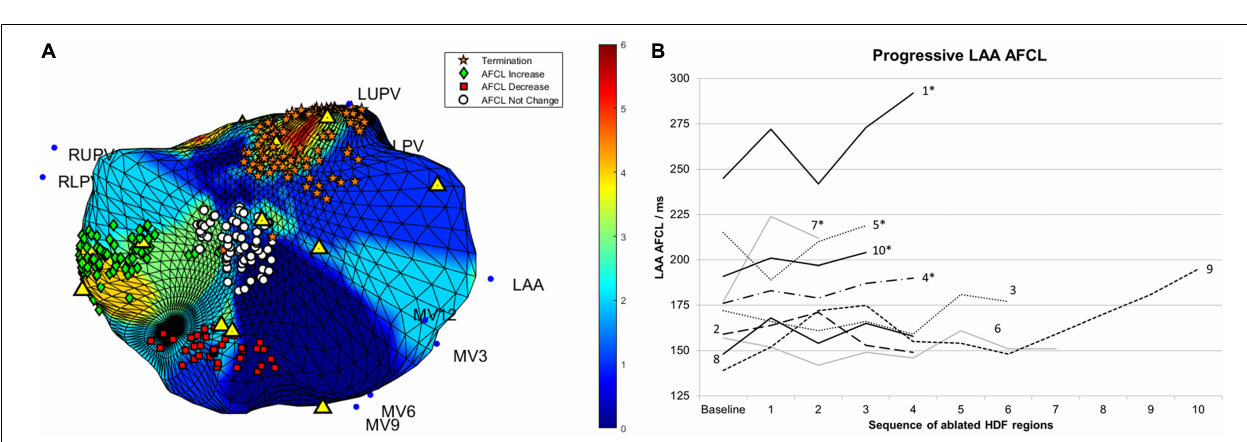
Analysis of Isopotential Maps The numbers of activation events per patient across all 51 ablation regions observed on 30 s pre-ablation isopotential maps are summarized in Table 3